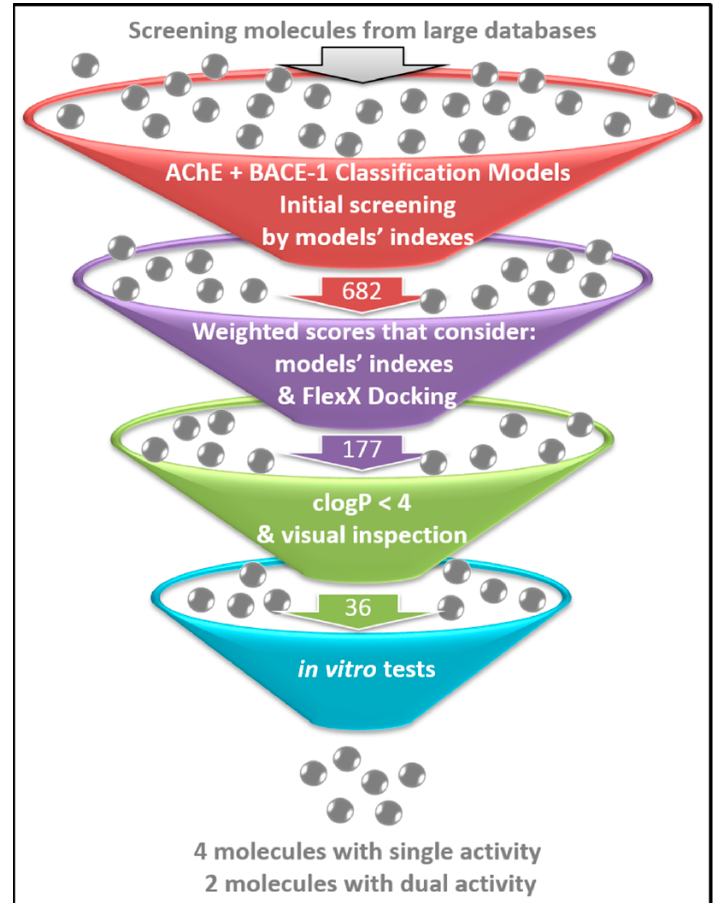
Figure 2. Research workflow: After the creation of ISE models for AChE and for BACE-1, large databases (Section 1.4) were screened by the models’ filters and 682 molecules had top scores in both. These molecules were docked by FlexX and were given weighted scores based on both the docking results and on ISE indexes (Supplementary Excel File, Table S10E). The 177 molecules with the highest weighted scores (Supplementary Excel File, Table S14E) were filtered again by calculated logP and visual inspection to obtain the final 66 molecules (Supplementary Excel File, Table S15E) of which 36 were purchased and sent for testing inhibitions of AChE and of BACE-1 (Supplementary Excel File, Table S16E). Six molecules inhibited either AChE or BACE-1, and two of them inhibited both enzymes (Supplementary Excel File, Table S17E). Details of the in vitro tests are given in Section 2.4 below and the results are presented in Supplementary Excel File, Tables S16E and